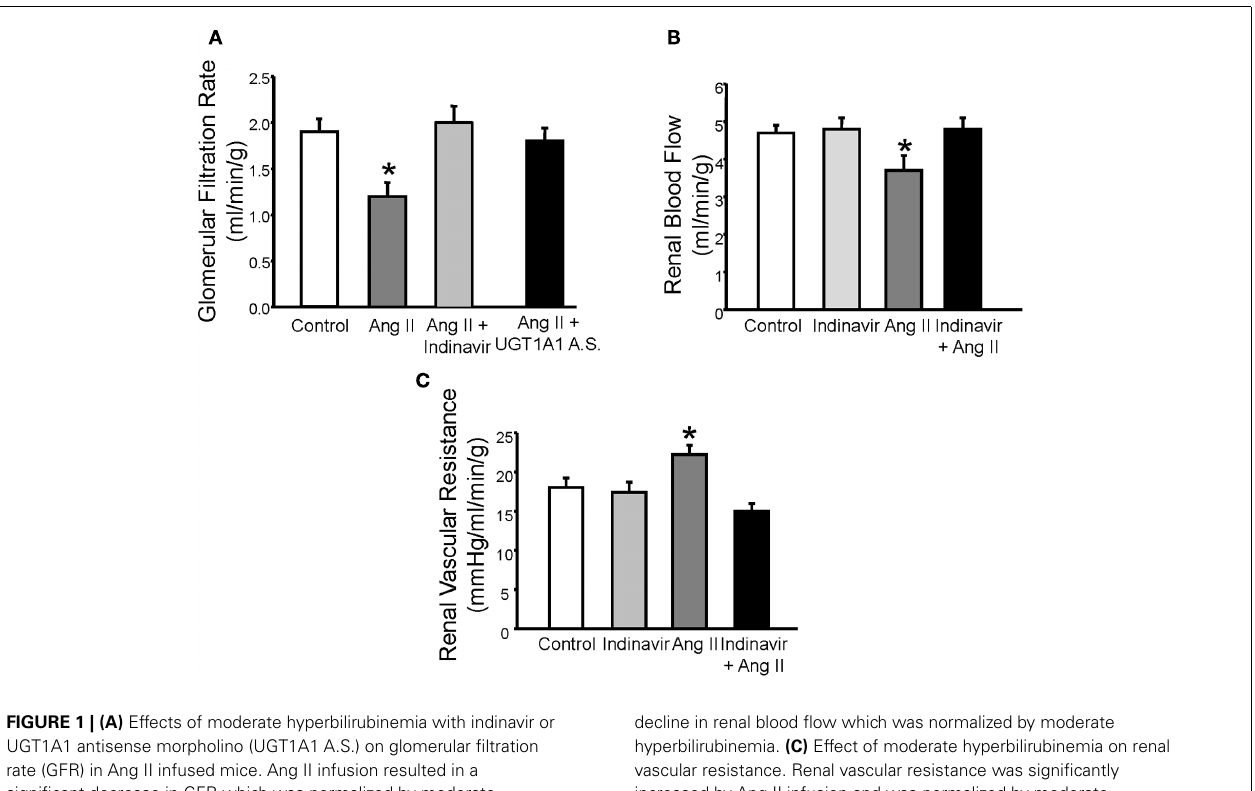
FIGURE 1 | (A) Effects of moderate hyperbilirubinemia with indinavir or UGT1A1 antisense morpholino (UGT1A1 A.S.) on glomerular filtration rate (GFR) in Ang II infused mice. Ang II infusion resulted in a significant decrease in GFR which was normalized by moderate hyperbilirubinemia. (B) Effect of moderate hyperbilirubinemia with indinavir on renal blood flow. Ang II infusion resulted in a significant